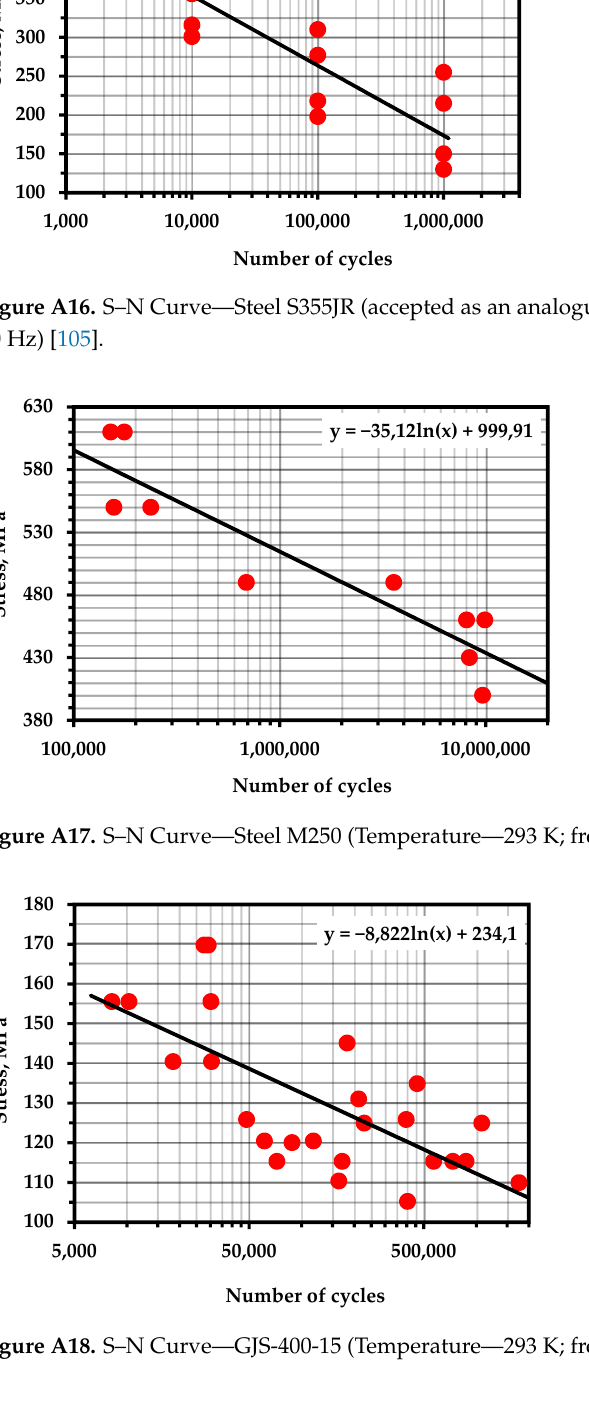
Figure A19. S–N Curve—Al 5052 alloy (Temperature—293 К ; frequency—4 Hz). Source—Base Total Material. References 1.